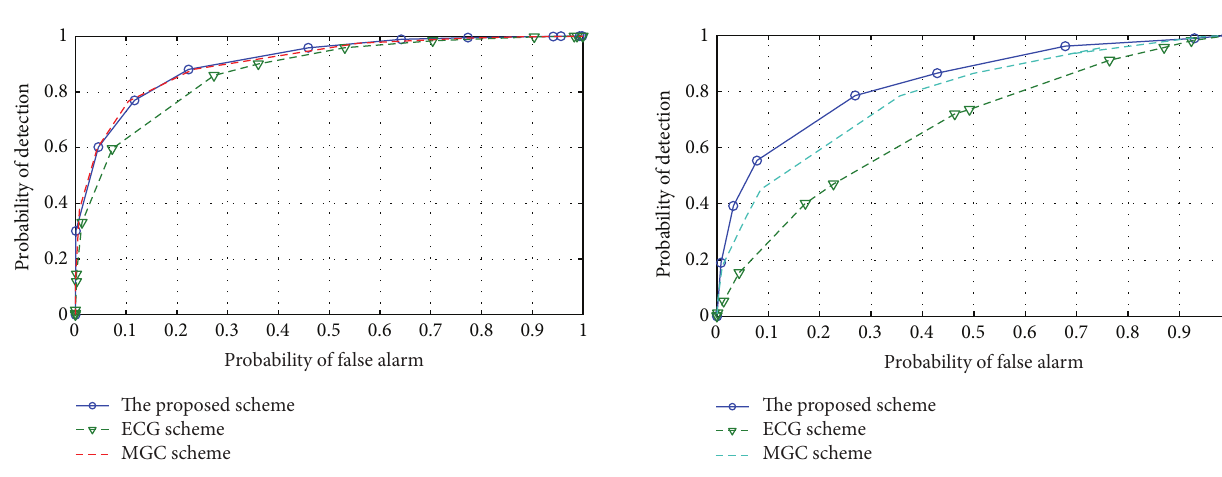
Figure4:ROCoftheproposedschemeandreferenceschemeswhen 4 always Yes malicious CUs are considered.